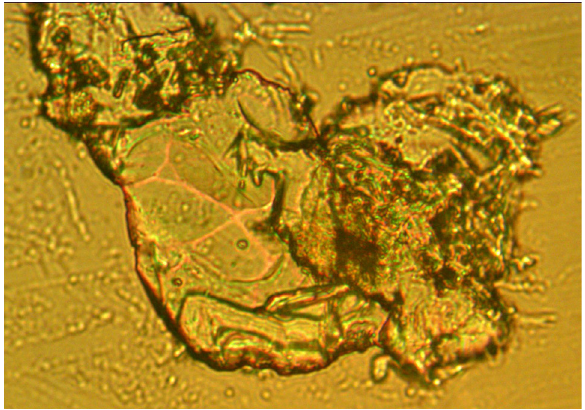
Figure 6 Microstructure of a pectin solution (100×